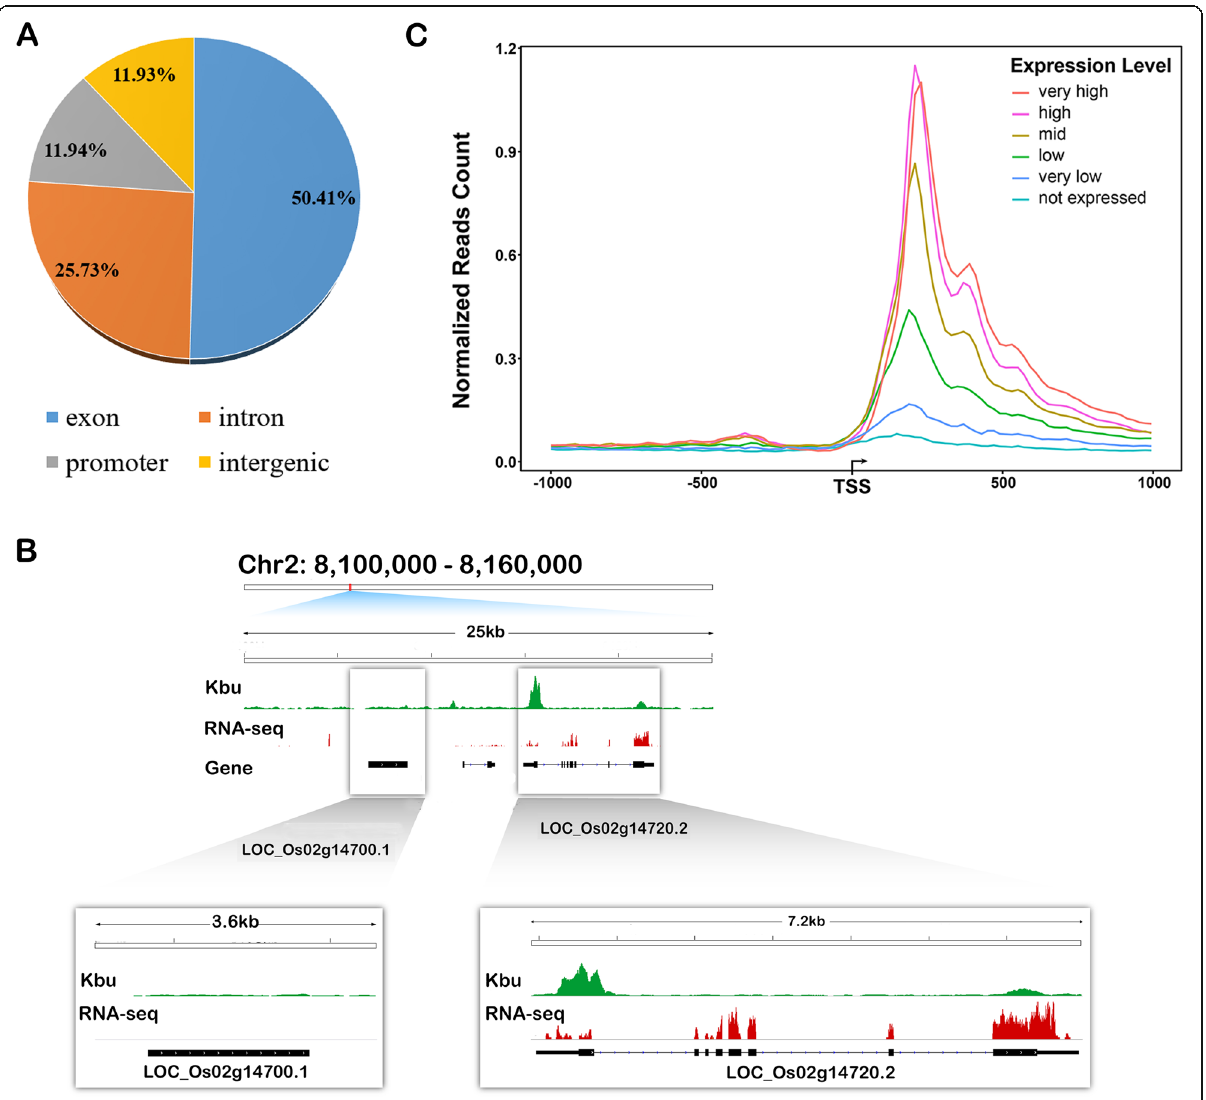
Fig. 2 The genomic distribution of histone Kbu-enriched regions in rice. a Genome-wide distribution of histone Kbu in the rice genome. The promoter regions are defined as the 1 kb of DNA sequence directly upstream of the gene transcription start site (TSS). b Mapping of Kbu sites, RNA-seq reads and gene loci in a 60,000 base pair region on Chr2:8,100,000 – 8,160,000. c Distribution of Kbu density around differentially expressed genes. The Kbu modification level was calculated by the number of reads per kilobase in the mapped genomic region. The arrow indicates the direction of transcription from the transcription start site (TSS). The rice genes were divided into six categories based the expression level from the top 20% to the bottom 0% based on published RNA-seq data from seedlings of the same rice cultivar at the same stage of development (Zhang et al.